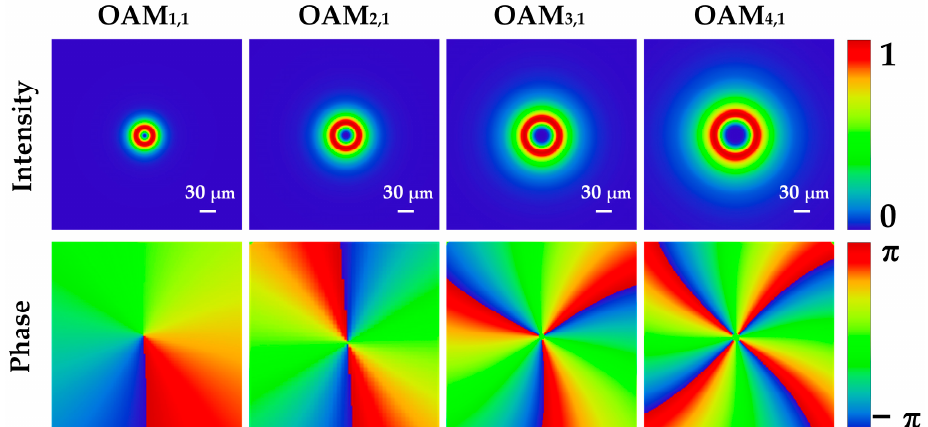
Figure 2. The normalized field intensity and phase distribution of OAM